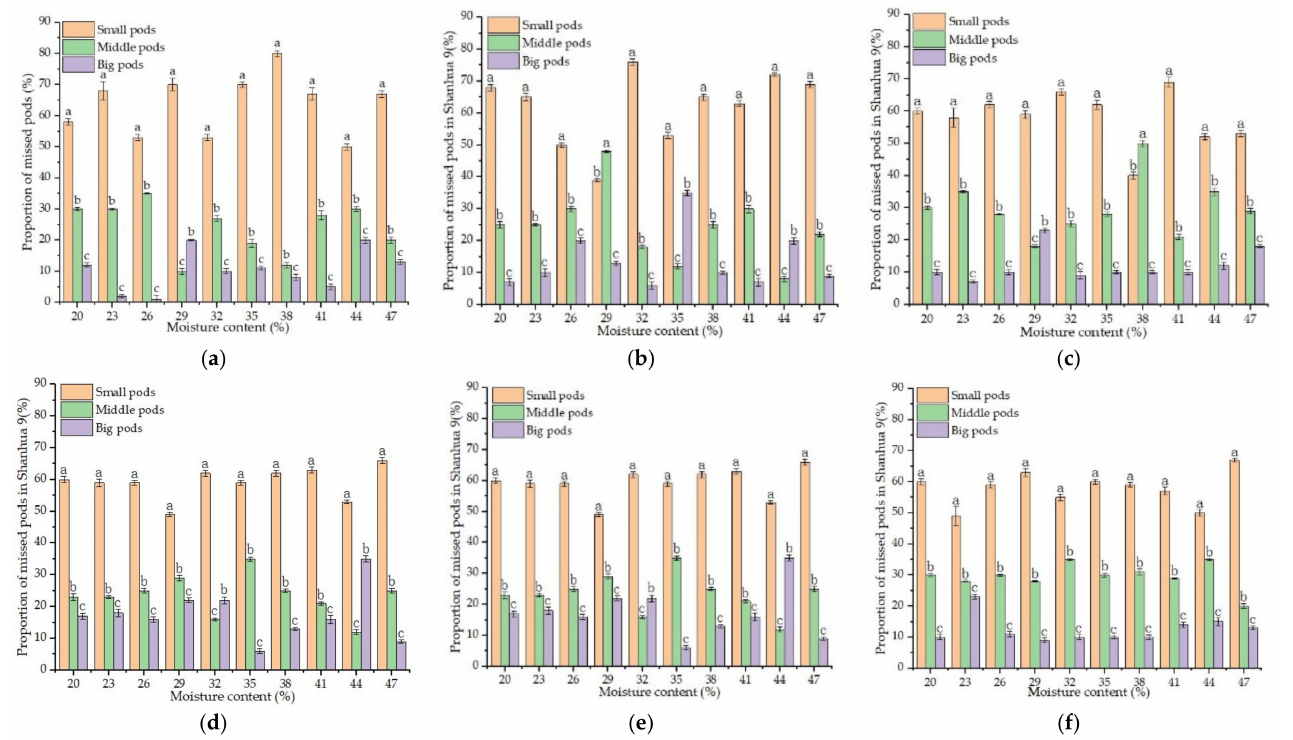
Figure 9. Distribution of two kinds of missed peanuts under different experimental treatments: ( a ) 2021 T1 Shanhua 9; ( b ) 2021 T2 Shanhua 9; ( c ) 2021 T3 Shanhua 9; ( d ) 2021 T1 Huayu22; ( e ) 2021 T2 Huayu22; ( f ) 2021 T3 Huayu22, different lowercase letters in the pictures indicate significant